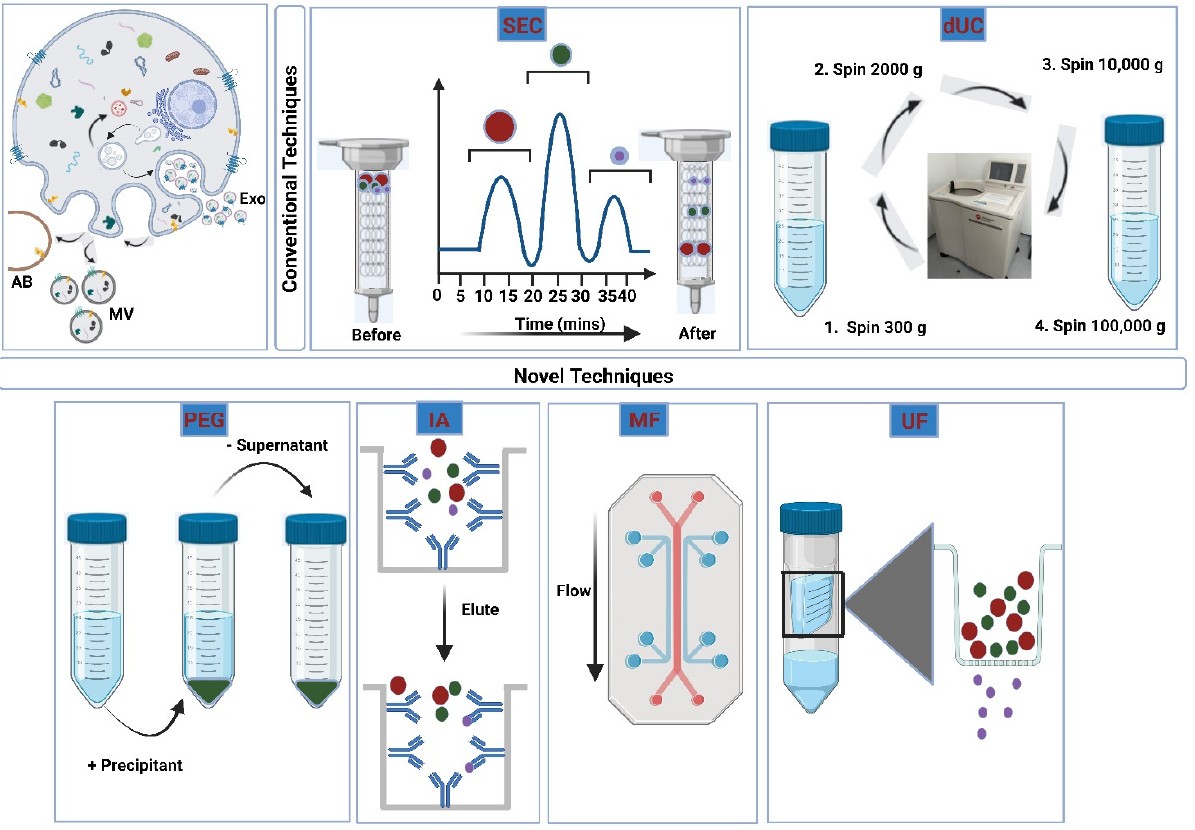
Figure 5. EVs biogenesis-based categorization into; apoptotic bodies (AB), microvesicles (MV), and exosomes (Exo). Methods of EVs isolation include; size-exclusion chromatography (SEC), differential ultracentrifugation (dUC), polyethylene glycol (PEG)-based precipitation, immunoaffinity (IA), microfluidics (MF), and ultrafiltration